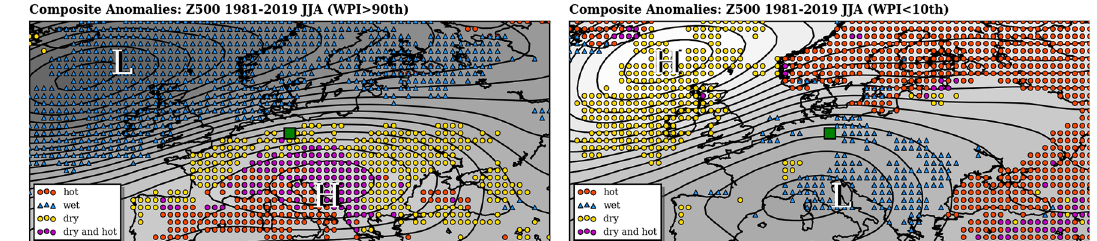
Figure 5. Composite patterns of Z500 anomalies from 1981 to 2019 related to 1981–2010 and Jun–Aug: WPI > ◦ ◦ 90th ( a ) and WPI < 10th ( b ) at the grid cell 52.0 N/12.0 E (green square) over Central Europe. Also added are hot anomalies (red, + 1.5 K), wet anomalies (blue, + 1.5 mm/d), dry anomalies (yellow, − 1.5 mm/d) and both hot-dry (magenta). The maps were created by using python3-mpltoolkits.basemap (version 1.2.1, https:// matpl otlib. org/ basem ap/).